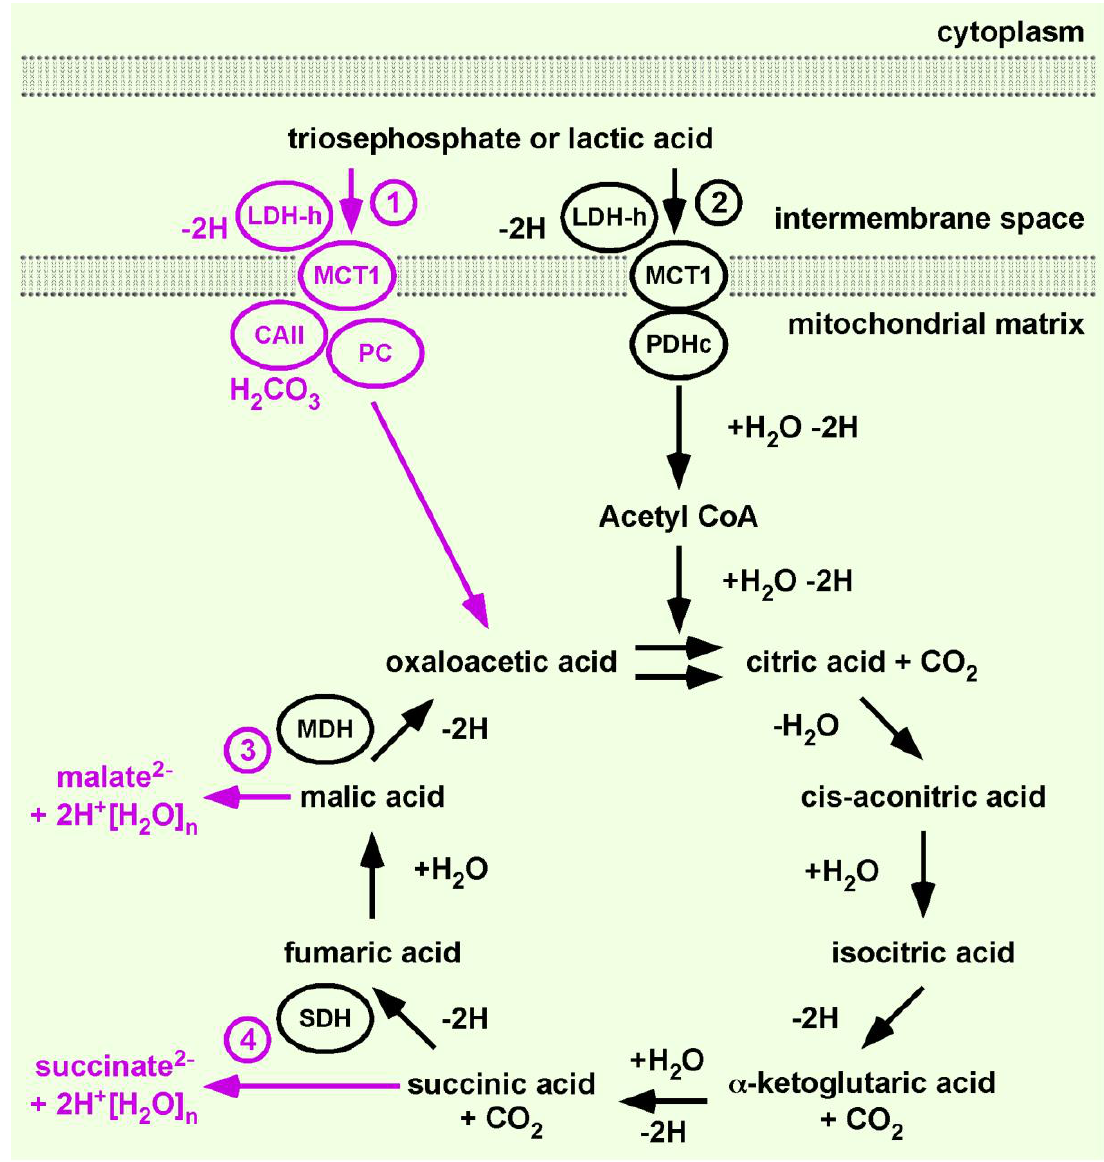
Figure 3. Citric Acid Cycle 1.1. 1 (cid:13) The heart lactate dehydrogenase (LDH-h) • proton-linked monocarboxylate transporter 1 (MCT1) complex, which catalyses the first reaction of oxaloacetic acid synthesis and the Citric Acid Cycle 1.1, is added to the cycle (magenta). Carbonic anhydrase II (CAII) provides the flow of carbonic acid (H 2 CO 3 ) necessary for the proton-linked MCT1 catalysed membrane transfer of pyruvic acid. Pyruvate carboxylase (PC) then converts pyruvic acid to oxaloacetic acid. 2 (cid:13) Concomitantly, the LDH-h • proton-linked MCT1 complex transfers pyruvic acid to the pyruvate dehydrogenase complex (PDHc), which provides Acetyl CoA to the Citric Acid Cycle 1.1. All acids cycle within the cycle. 3 (cid:13) A relative inactivity of malate dehydrogenase (MDH) causes a ‘metabolic traffic jam,’ and excess malic acid shunted to a mitochondrial pool of carboxylates as malate 2 − . 4 (cid:13) A relative inactivity of succinate dehydrogenase (SDH) regulates the release of succinic acid into the pool of carboxylates as succinate 2 − . Note: This illustration contains an extract from the image shown in H. A. Krebs’ Nobel Prize lecture in 1953 and first published 1937 [41–43]. ©The Nobel